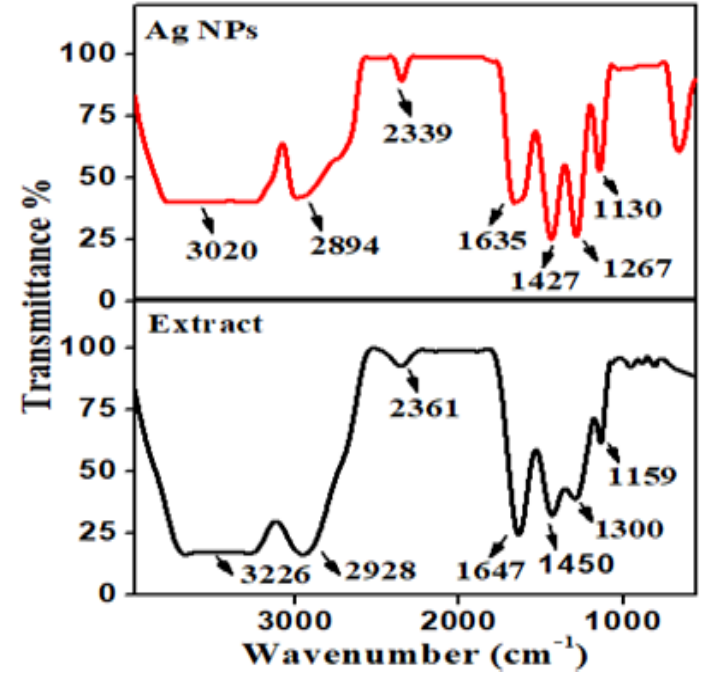
Figure 2. FT-IR combined spectra for Ag NPs and plant extract.